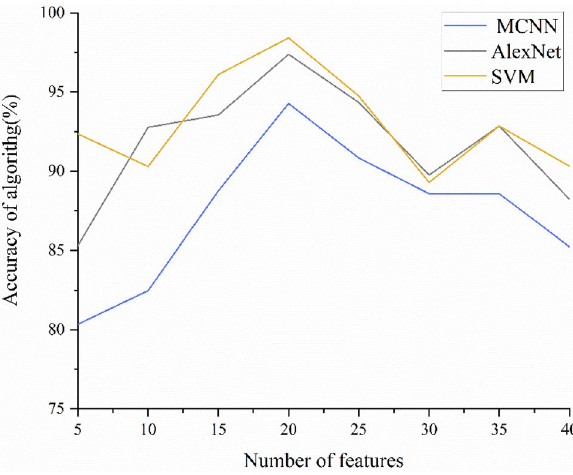
Figure 7. Validation set accuracy of SVM, AlexNet and